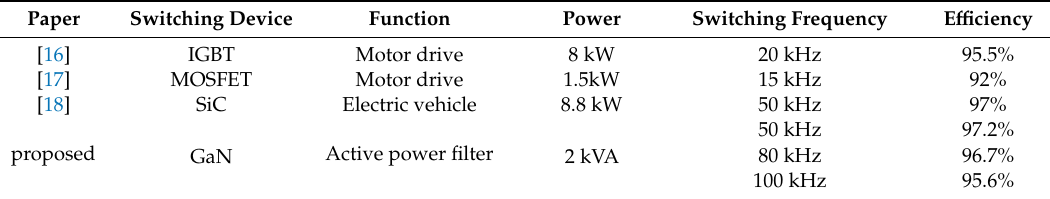
Table 5. Performance comparison of di ff erent